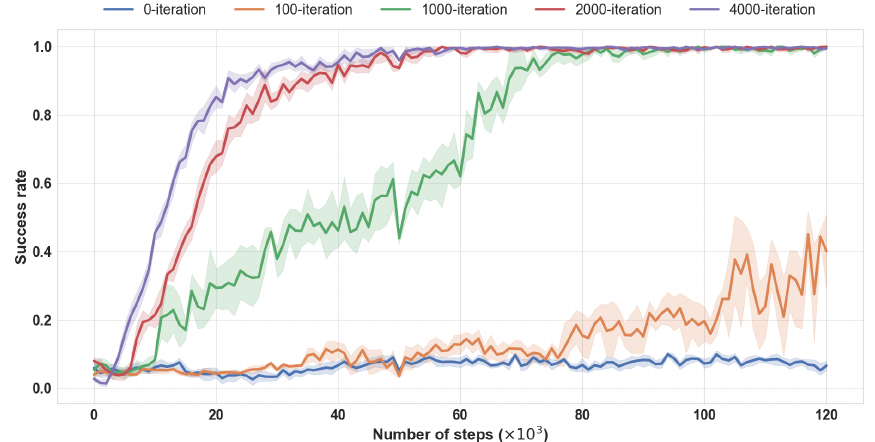
Figure 6. Performance of pre-training iterations ablation. Training performances (success rate) of with pre-training iteration times in Pick-and-Place task. Mean and std. deviation of 25